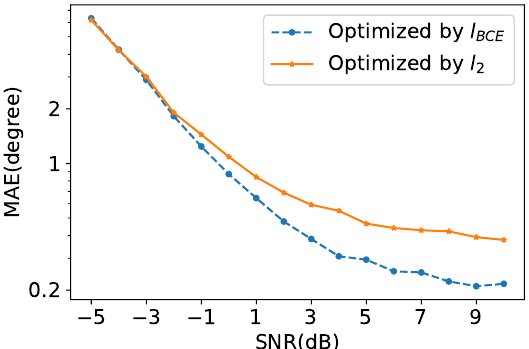
Figure 3. MAE comparison of the classification branch optimized by l BCE and by l 2 .